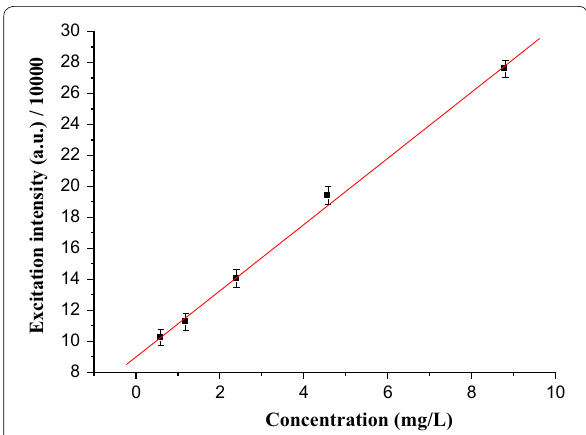
Fig. 7 Graph of maximum excitation intensity vs concentration of standard caffeine